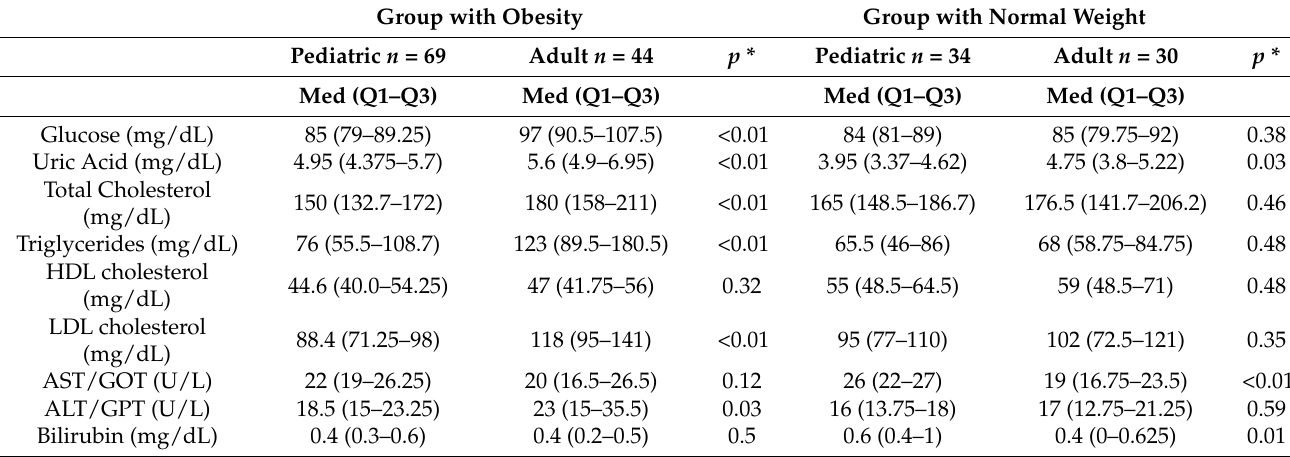
Table 2. Biochemical values measured in plasma in a fraction of the observed groups. Group with Obesity Group with Normal